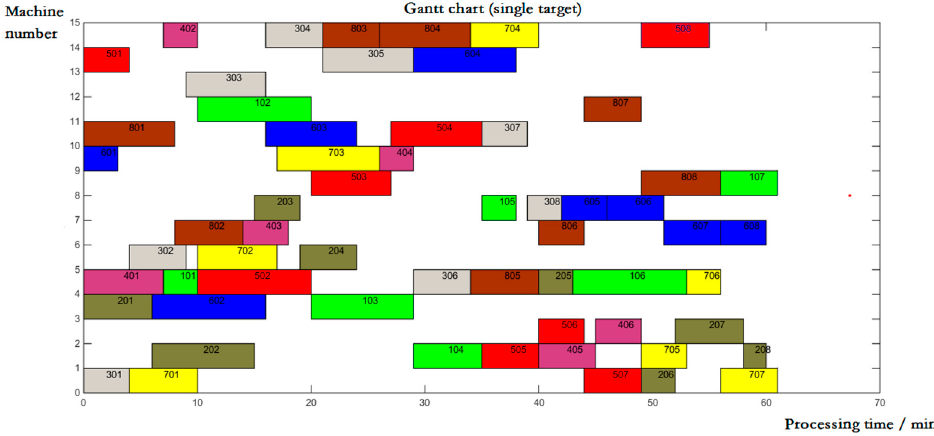
Figure 5. Single-target optimization result Gantt chart.